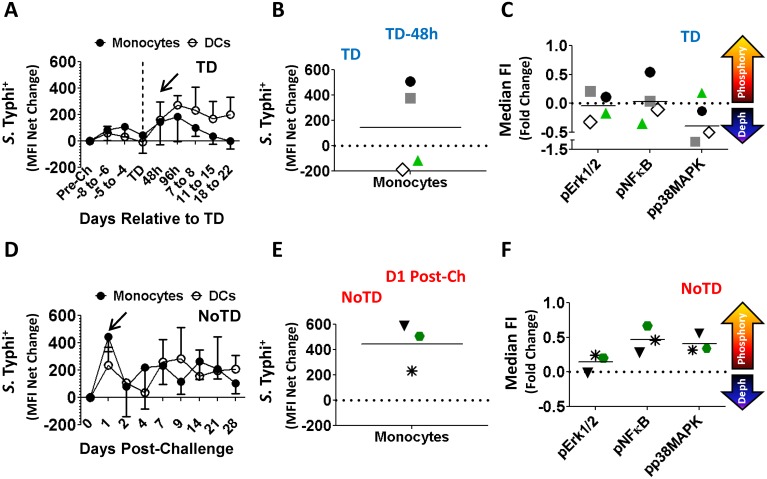
Ability of monocytes to bind S. Typhi and activation of signaling pathways following wild-type challenge.Time courses of S. Typhi (killed-fluorescently labeled) binding to circulating monocytes from TD (A) and NoTD (D) volunteers. Shown in panels B and E are the binding data of individual volunteers at the peak time for TD (TD-48h) and NoTD (D1 Post-challenge) participants, respectively. Each volunteer is indicated by a defined symbol and color, which is also used to represent the data in panels C and F. The horizontal solid lines indicate the mean. Shown in panels C and F are the phosphorylation profiles of Erk1/2, pNFκB and p38MAPK following stimulation with S. Typhi-LPS QD-655micelles in TD and NoTD volunteers, respectively, at peak avidity. The data is presented as fold changes at peak S. Typhi binding compared to pre-challenge. The dotted line indicates no changes in phosphorylation and the horizontal lines represent the mean.